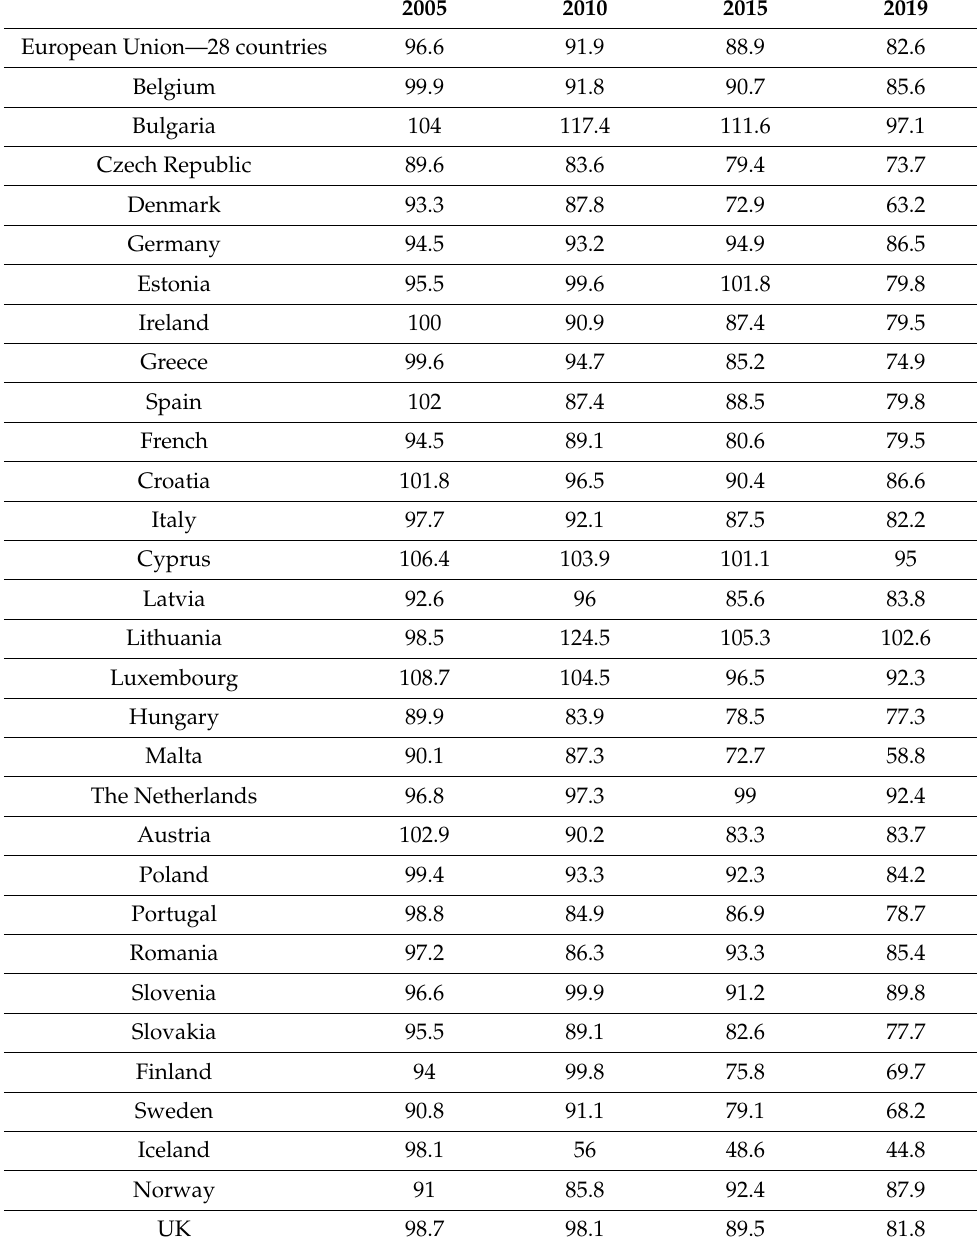
Table 2. Intensity of greenhouse gas emissions of energy consumption in the European Union (Year 2000 =